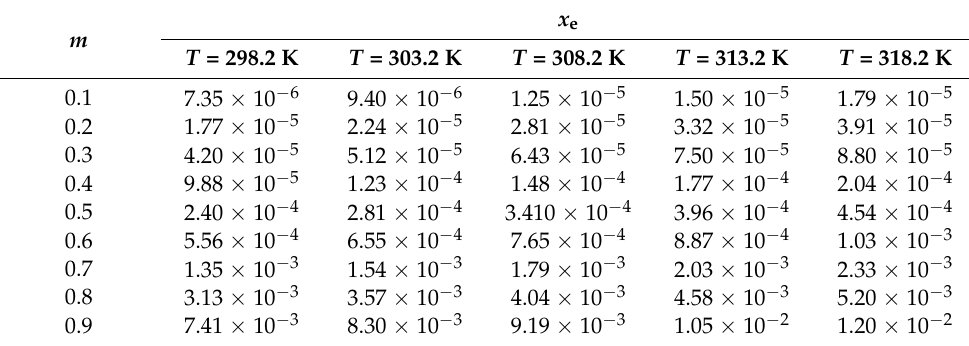
Table 2. The x e values of TRV against mass fraction of propylene glycol (PG; m ) in binary PG + water compositions at 298.2–318.2 K and 0.1 MPa b .